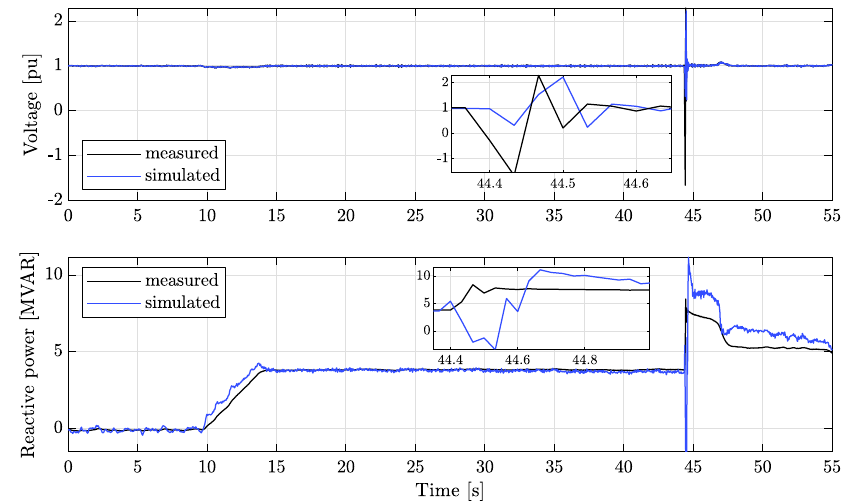
Figure 13. Volt/VAR Control Experiment 5: controlled external stimulus test (switching a capacitor bank). Comparison of simulations and experimental results.